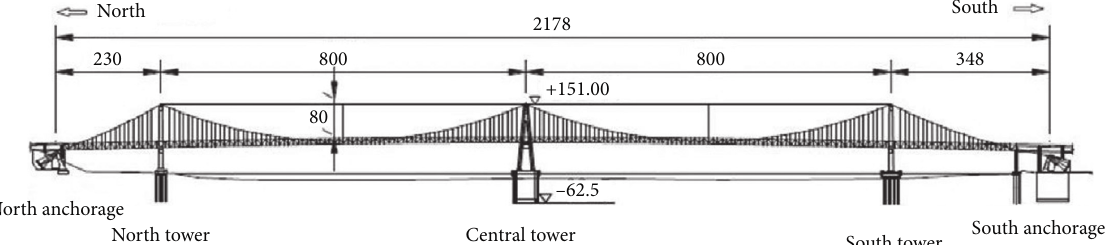
Figure 1: The elevation layout of main bridge (unit: m).